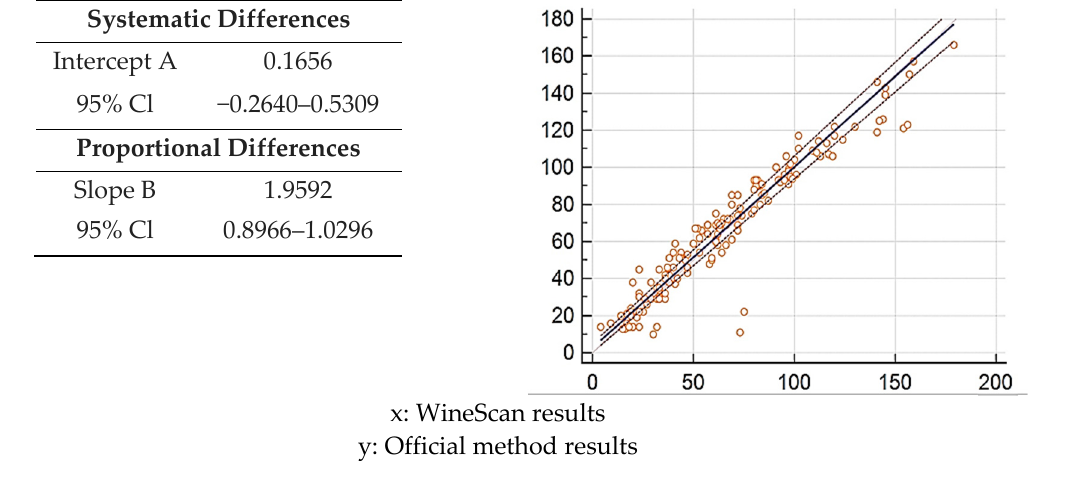
Figure 9. Passing & Bablok regression analysis of alcohol concentration results obtained by the official method and WineScan technology. The line y = x is represented by the dashed line. The regression line corresponds to the solid line.